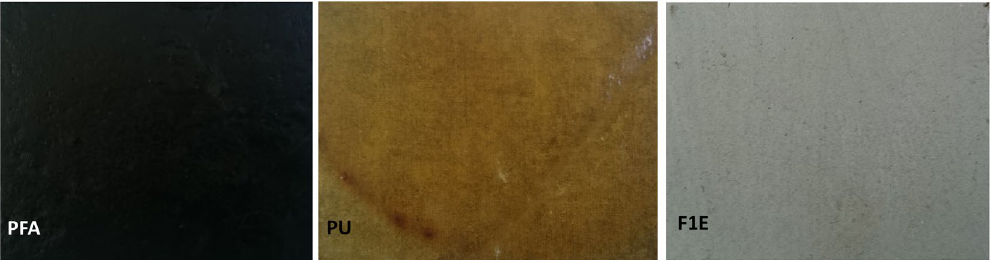
Figure 1. Flax/Phenolic laminates coated with polyfurfuryl alcohol (PFA), polyurethane (PU) and FIRESHELL ®